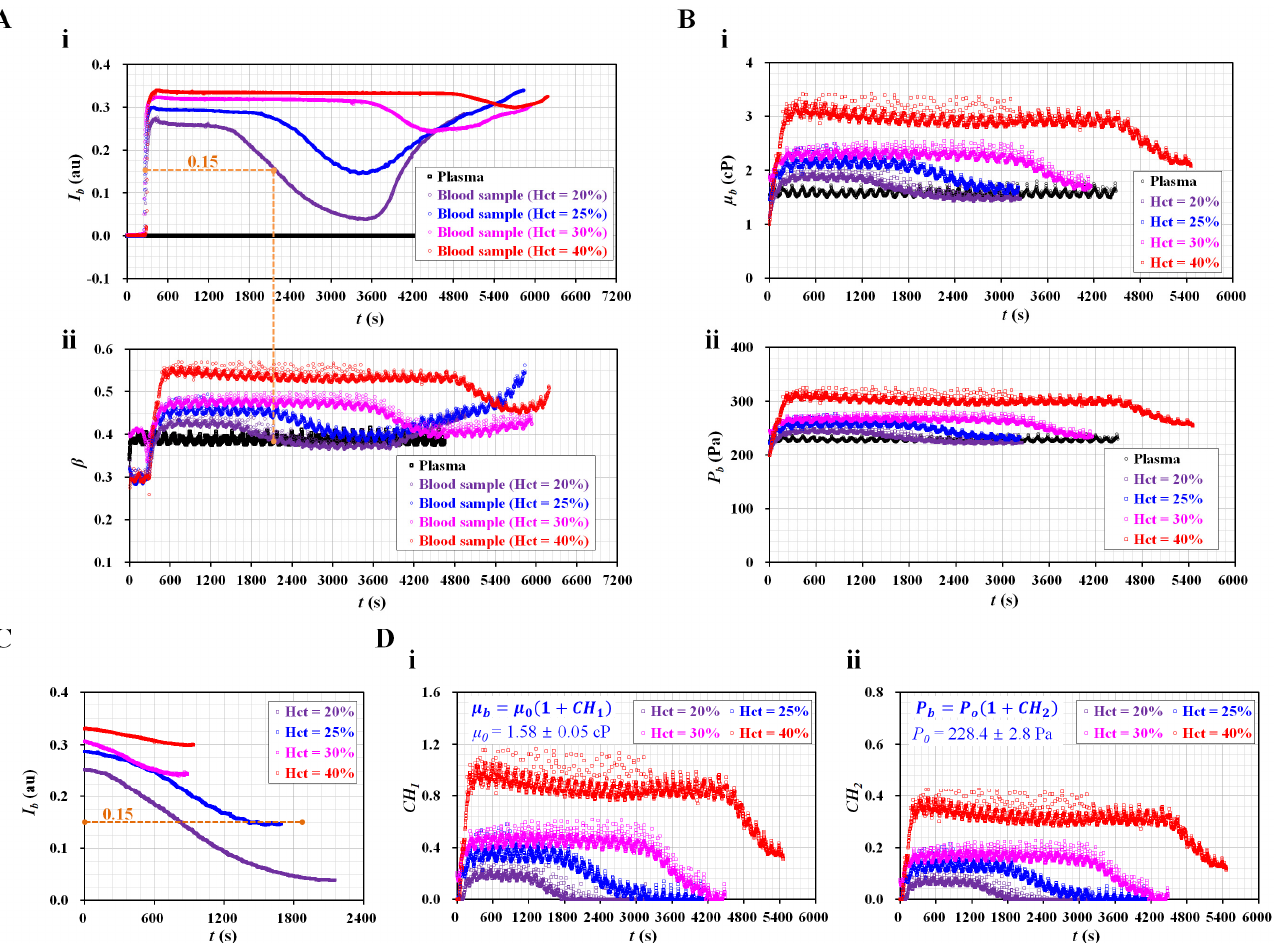
Figure 3. Quantitative evaluations of RBC sedimentation for the control blood. The hematocrit was adjusted to Hct = 20%, 25%, 30%, and 40% by adding normal RBCs into autologous plasma. ( A ) Temporal variations in I b and β with respect to Hct. ( A - i ) Temporal variations in I b with respect to Hct. ( A - ii ) Temporal variations in β with respect to Hct. ( B ) Temporal variations in µ b and P b with respect to Hct. ( B - i ) Temporal variations in µ b with respect to Hct. ( B - ii ) Temporal variations in P b with respect to Hct. ( C ) Temporal variations in I b with respect to hematocrit. Here, the I b was recollected from the time it began to decrease from flat value. ( D ) The contribution of RBC sedimentation to blood biophysical properties (blood viscosity and junction pressure). Two equations ( µ b = µ 0 [1 + CH 1 ] and P b = P 0 [1+ CH 2 ]) were used to separate the contributions of RBCs and diluent in terms of blood viscosity and blood junction pressure. ( D - i ) Temporal variations in CH 1 with respect to Hct. Here, µ 0 = 1.58 ± 0.05 cP. ( D - ii ) Temporal variations in CH 2 with respect to Hct. Here, P 0 = 228.4 ± 2.8 Pa.